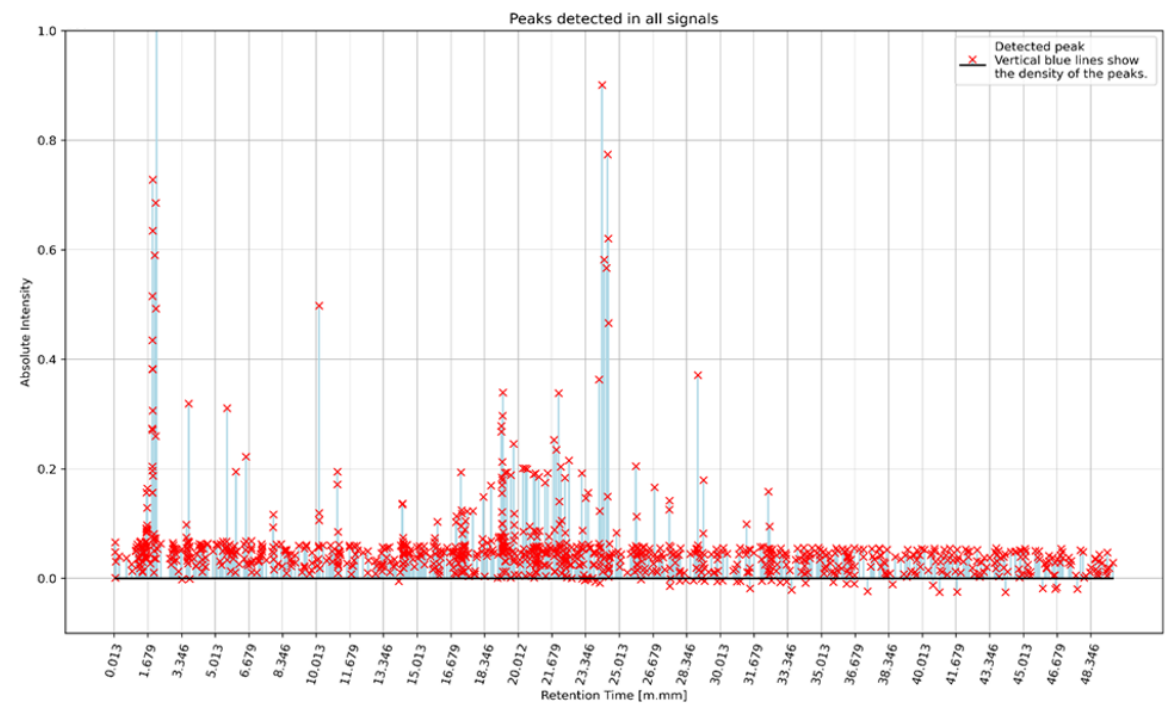
Figure 2. Intensity (maximum y value) and density of peaks on the x-axis in the recorded signals for the entire group of PAH patients.